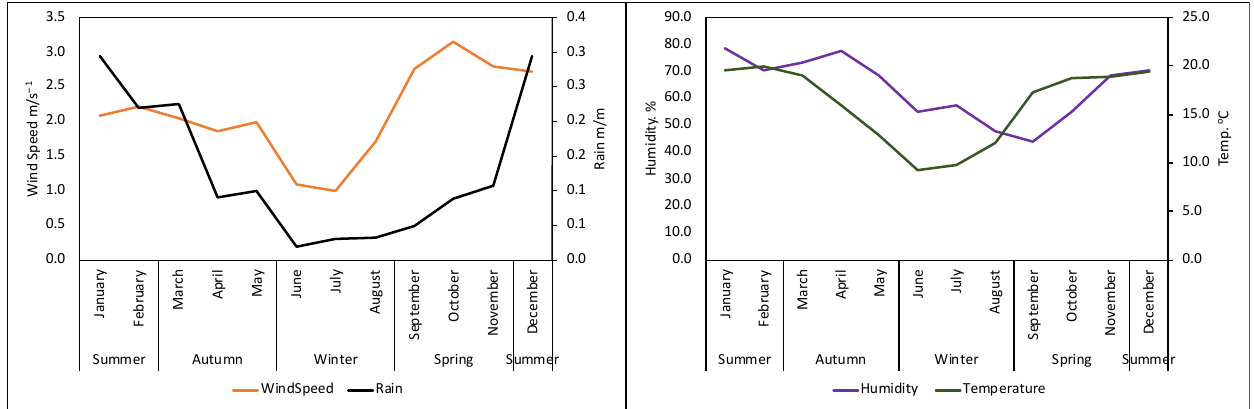
Figure 6. Seasonal atmospheric synoptic weather circulation system in South Africa. H represent High pressure, and L represent Low pressure.